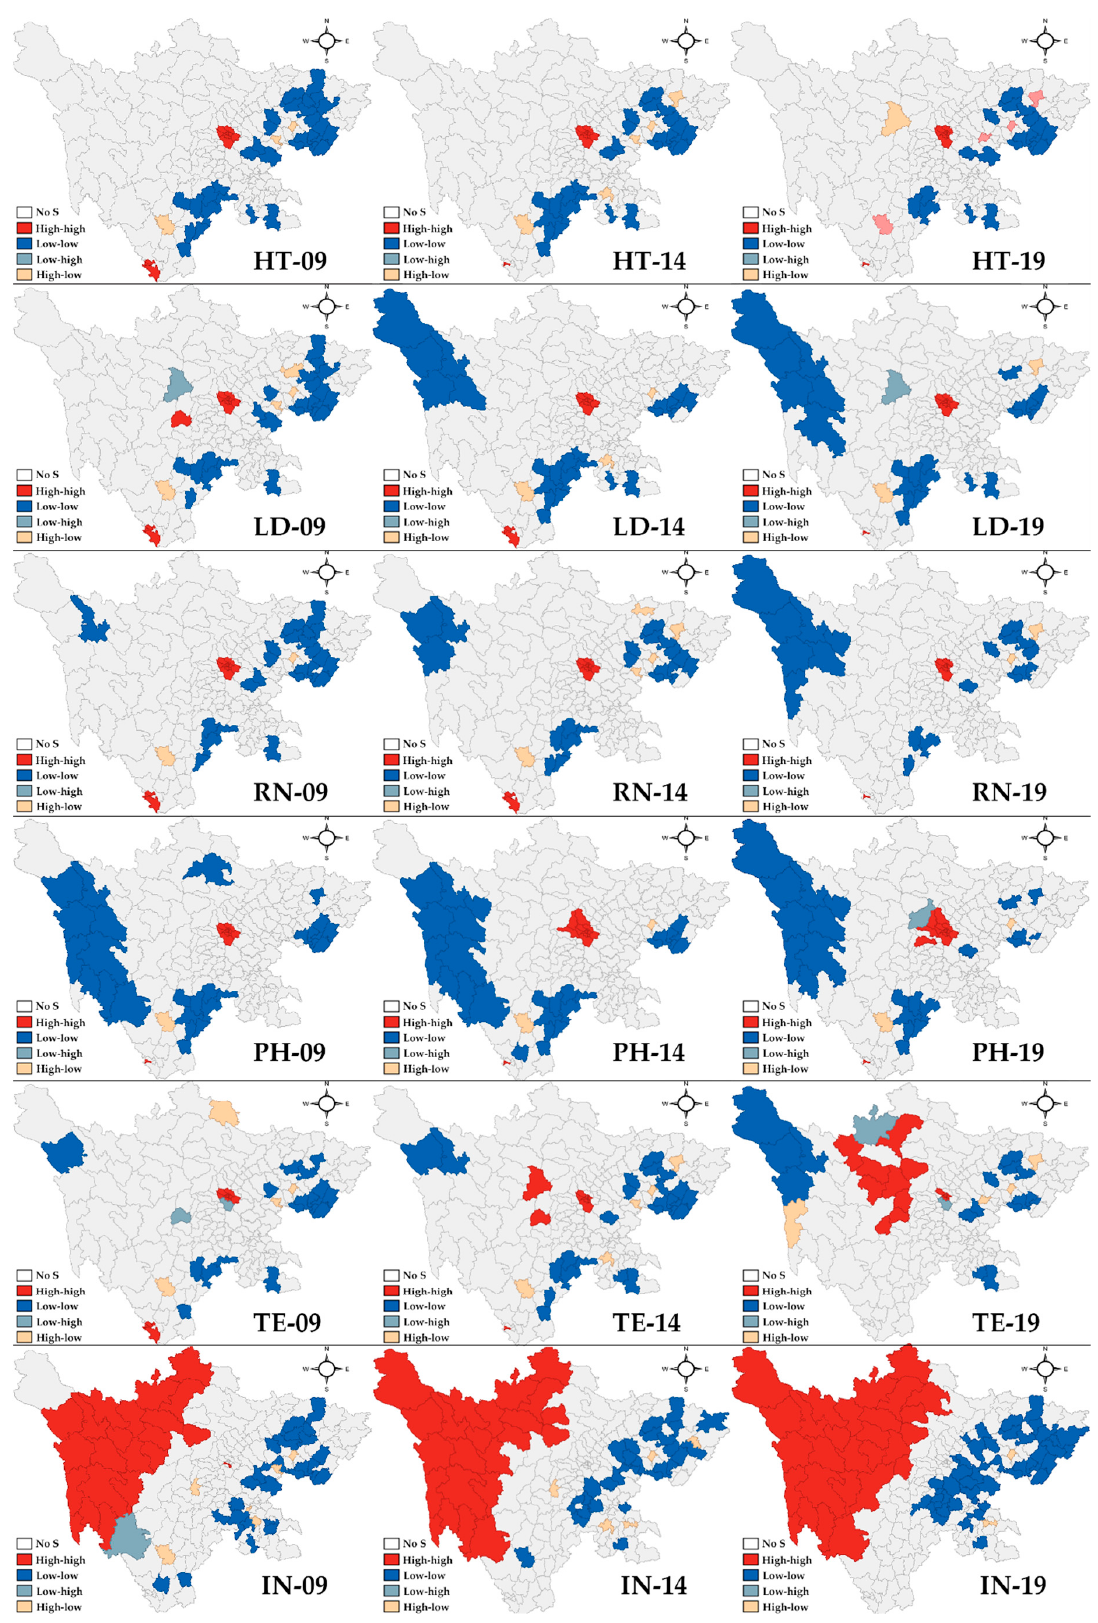
Figure 5. Spatial clusters of all types of healthcare professionals in 2009, 2014, and 2019. HT, health technician; LD, licensed doctor; RN, registered nurse; PH, pharmacist; TE, technologist; IN, intern.